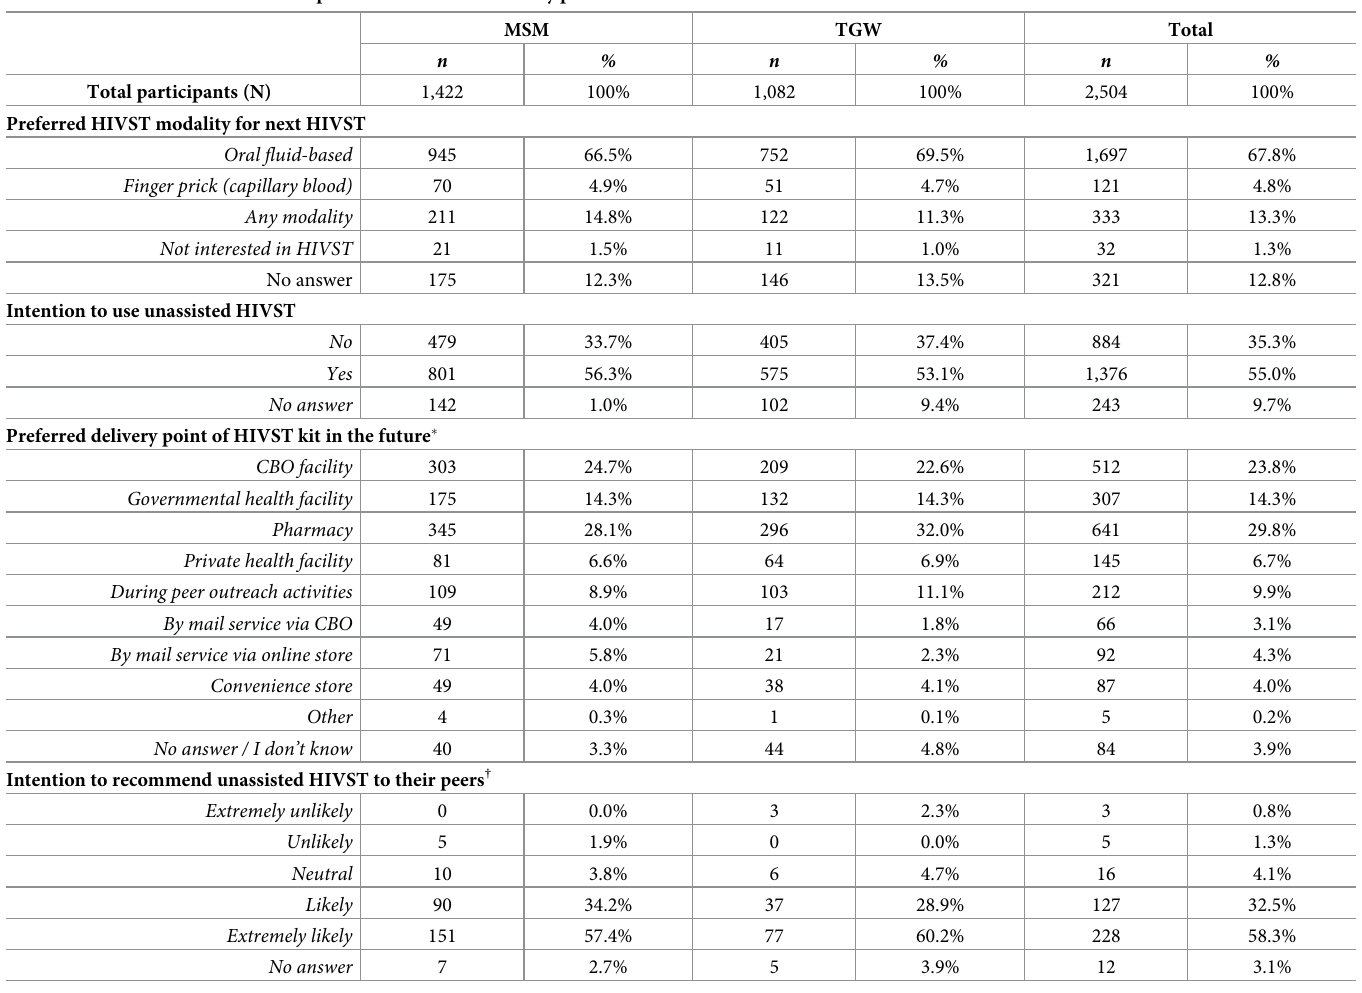
Table 7. Intention to use HIVST and preferred HIVST kit delivery